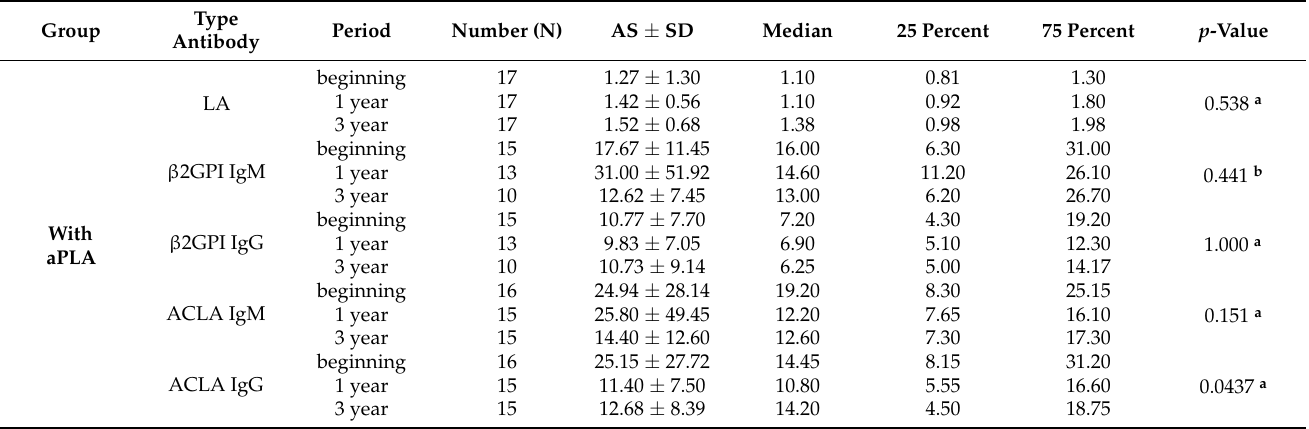
Table 3. Change in aPLA’s value during the follow-ups.